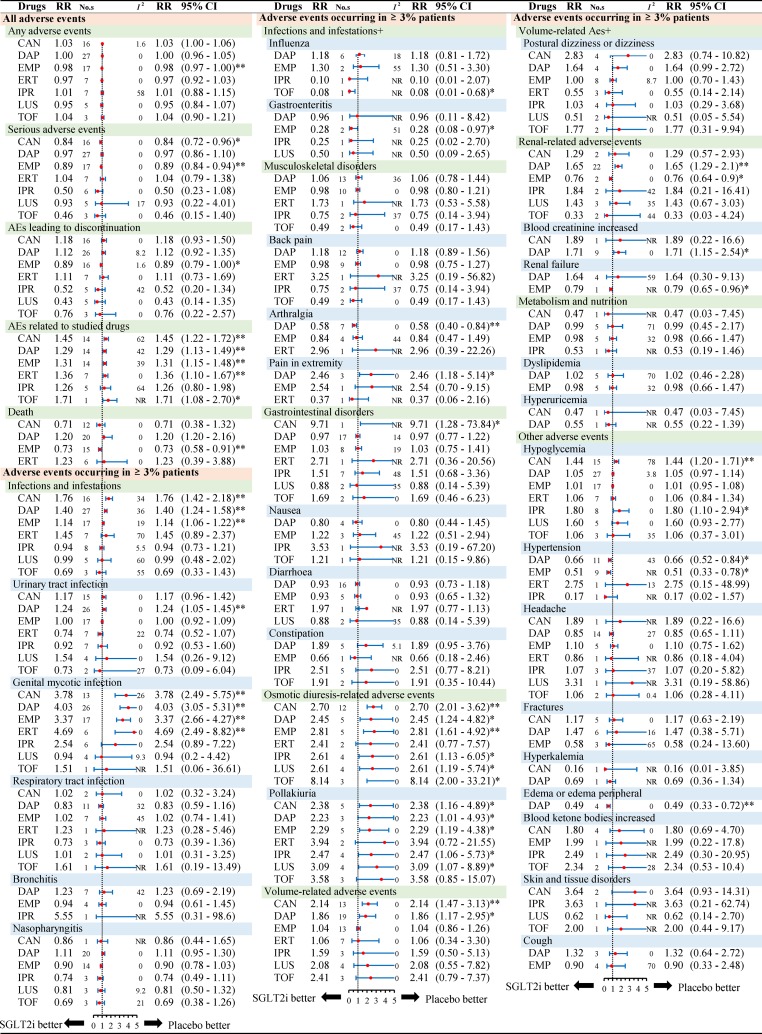
Subgroup analysis of relative risk of adverse events reported for each SGLT2i in comparison to placebo. Different colors represent different menu levels (pink > green > blue). Abbreviations: No.s, number of studies; NR, not required; CAN, canagliflozin; DAP, dapagliflozin; EMP, empagliflozin; IPR, ipragliflozin; TOF, tofogliflozin; LUS luseogliflozin; ERT ertugliflozin.* P < 0.05, ** P < 0.001.